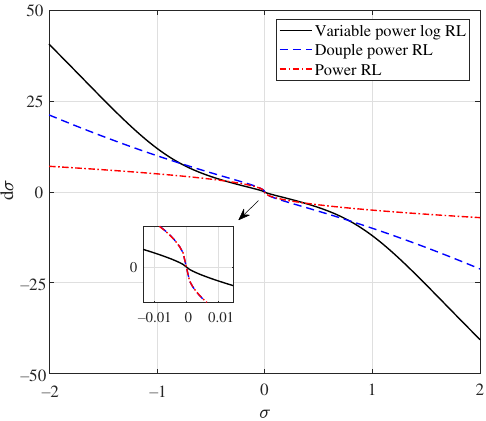
Figure 4. Sliding mode variable in the phase